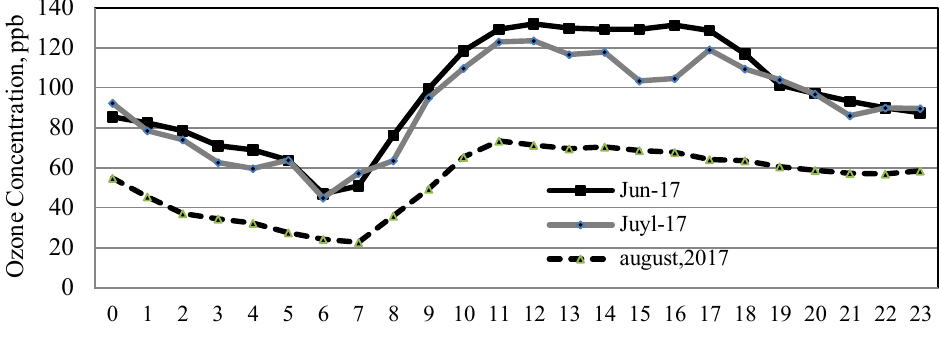
Figure 2. Hourly average of ozone concentration (ppb) for 3 months of 2017 in the